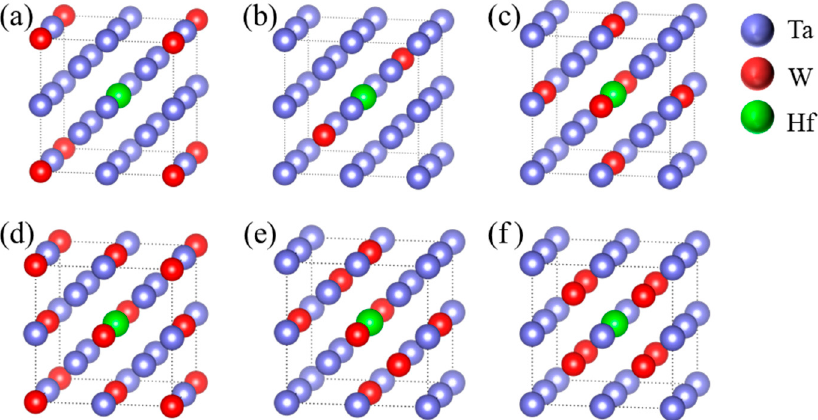
Figure 2. Atomic structure models of Ta–W–Hf alloys. ( a ) Ta–6.25W–6.25Hf, ( b ) Ta–12.5W–6.25Hf, ( c ) Ta–18.75W–6.25Hf, ( d ) Ta-25.00W–6.25Hf, ( e ) Ta–31.25W–6.25Hf, ( f ) Ta–50.00W–6.25Hf.